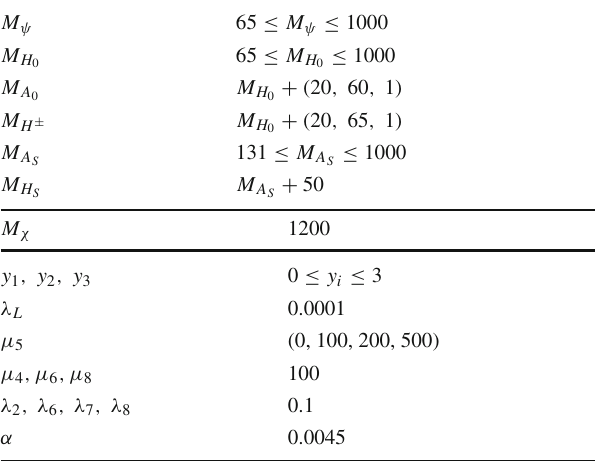
Table 2 Parameters considered for the DM relic density study in sce- nario 2. All mass parameters are in GeV M ψ 65 ≤ M ψ ≤